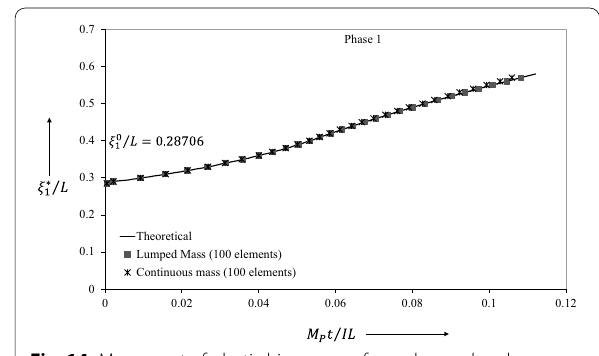
Fig. 14 Movement of plastic hinge away from clamped end ( P 0 = 12.5 P c )